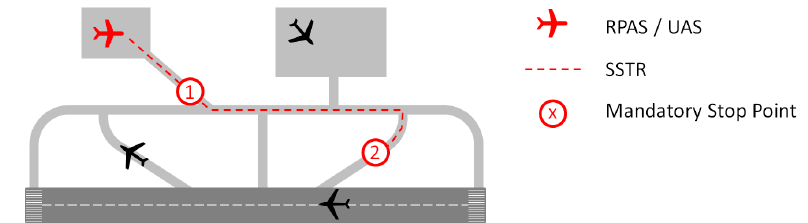
Figure 1. Sketch of a remotely piloted aircraft system (RPAS) taxi out movement using the proposed procedure. UAS = unmanned aircraft systems; SSTR = Segmented Standard Taxi Routes.